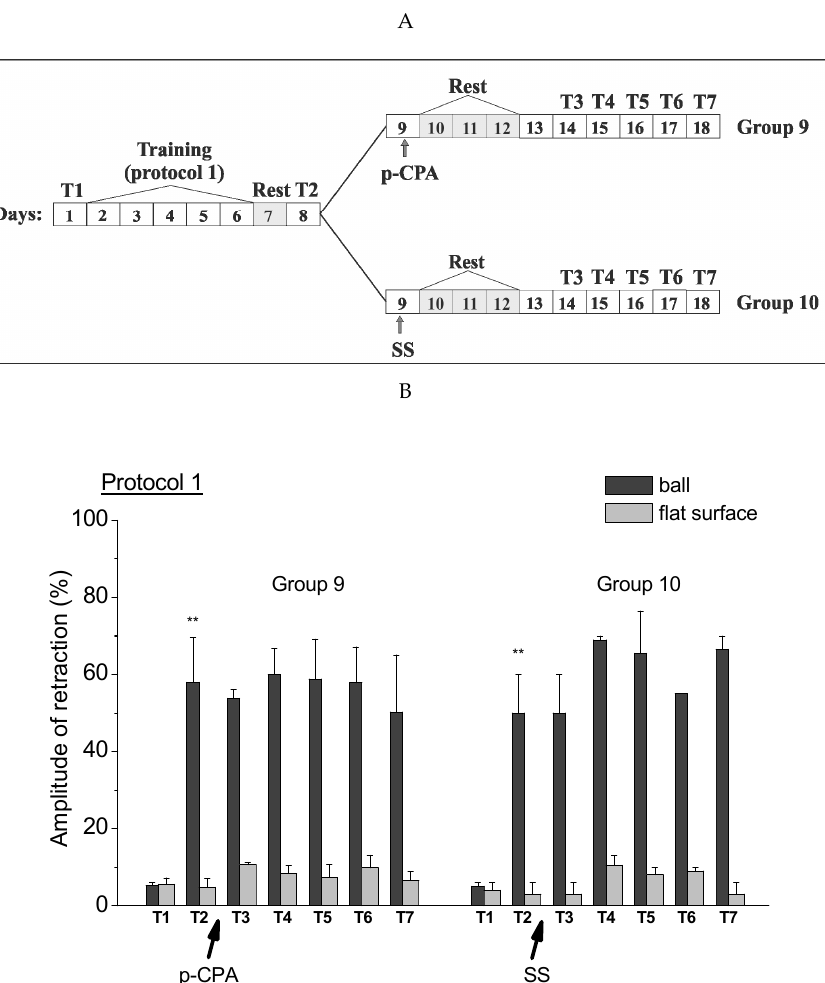
Figure 4. A. Scheme of the experimental series 3 (protocol 1; Groups 9 and 10). In the boxes indicated the days of the experiment. 1 day (T1)—initial testing of the level of defensive reactions, 2–6 days (Training)—development of the conditioned reflex in the context paradigm, Day 7 (Rest)—rest, Day 8 (T2)—testing of the level of the defensive reaction after the procedure of training. Group 9 “PCPA” and group 10 “SS”: Day 9—injection of PCPA/SS, 10–12 days (Rest)—rest, 13 day (Rest)—rest, 14–18 days (T3, T4, T5, T6 and T7)—testing of the level of the defensive reaction after the reminder session. B.